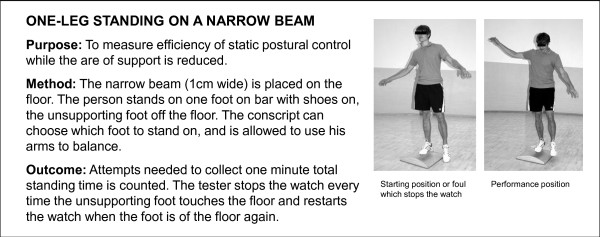
Description of one-leg standing on a narrow beam test. The test was performed for study purposes.